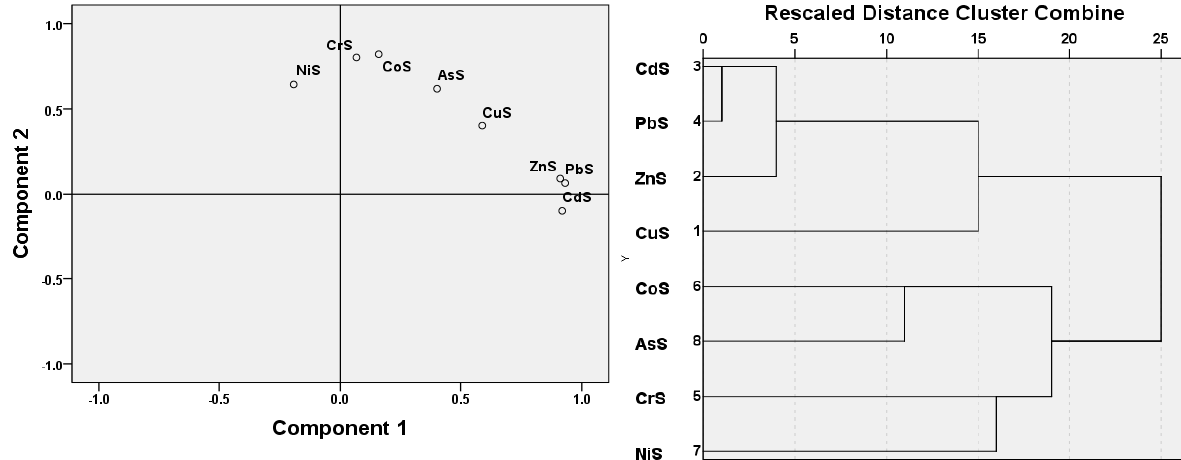
Figure 3. Scatter plots and cluster tree of trace elements in